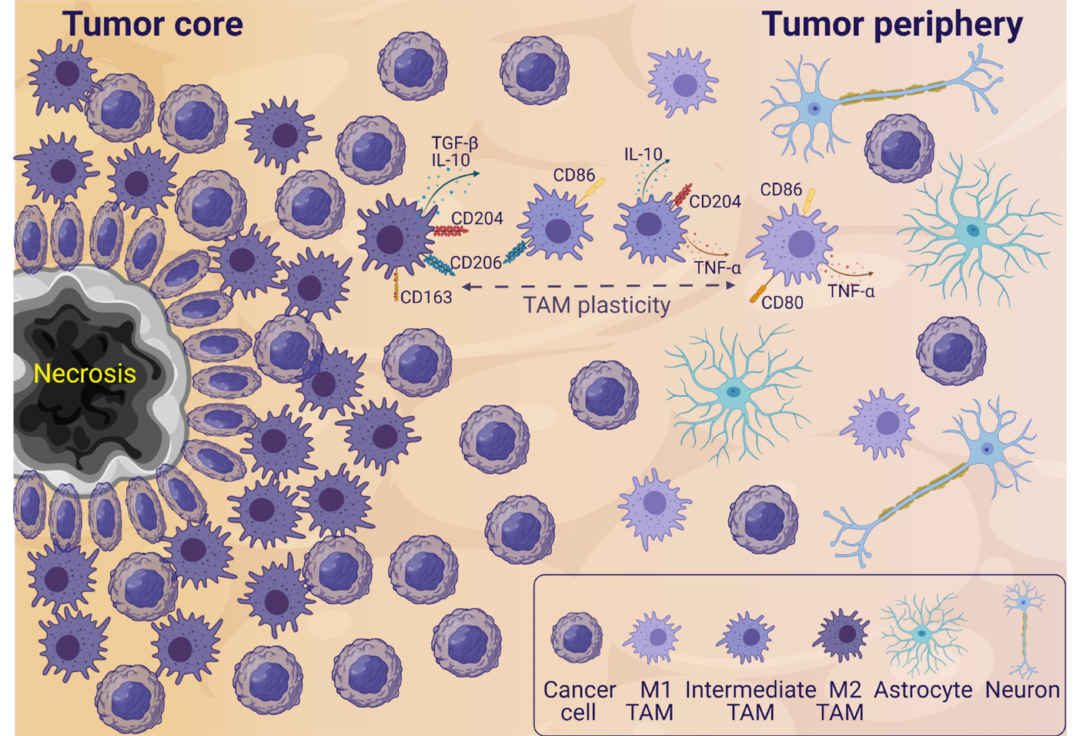
Figure 1. Simplified glioblastoma microenvironment illustrating a section of a tumor with both tumor core and peripheral areas. In the tumor core, a necrotic area surrounded by pseudopalisading cells is shown. Necroses surrounded by pseudopalisading cells is a glioblastoma hallmark. Anti-inflammatory M2-like tumor-associated microglia and macrophages (TAMs) are mainly infiltrating the tumor core, and pro-inflammatory M1-like TAMs are mainly infiltrating the tumor periphery. Intermediate TAMs co-expressing M1 and M2 markers are also observed in the tumor microenvironment (TME). In the periphery, there is a higher presence of non-cancer cells like astrocytes and neurons, while the tumor core is more dense with cancer cells and TAMs. More cells are present in the TME—this is a simplified illustration. Abbreviations: transforming growth factor beta (TGF- β ), interleukin (IL), tumor necrosis factor alpha (TNF- α ). Created with BioRender.com (accessed on 16 August